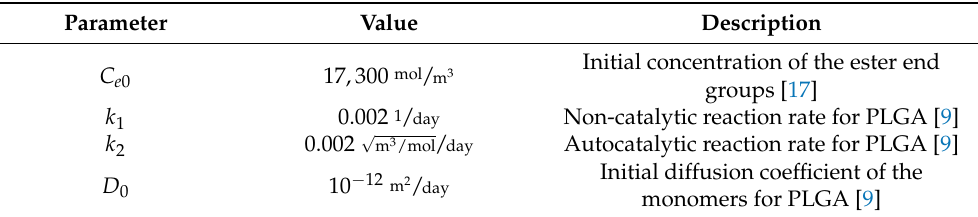
Table 1. Parameters used for the model implemented in COMSOL Multiphysics ® for PLGA. Parameter